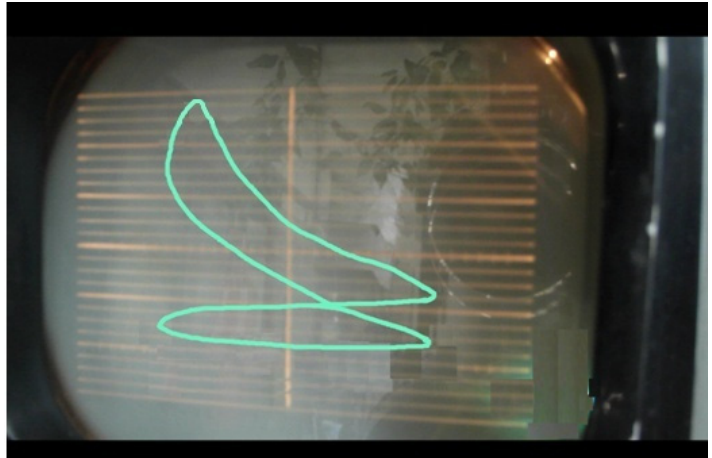
Figure 2. Indicated PV diagram for spark ignition operation mode. Because the engine draws air directly from the atmosphere and is operated at a constant speed, the intake air flow is constant. After measuring the quantity of intake air resulted in an air flow of 12.9 m 3